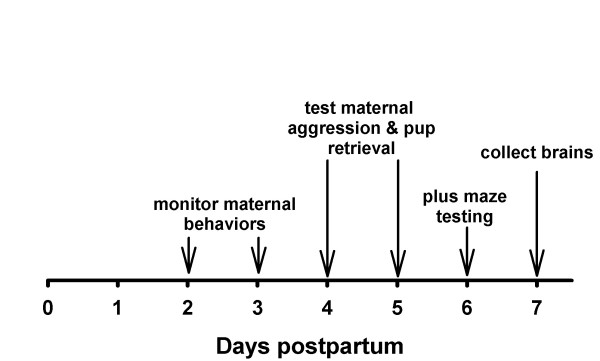
Overview of the timeline for behavioral observations and testing. Birth of pups is considered postpartum Day 0.